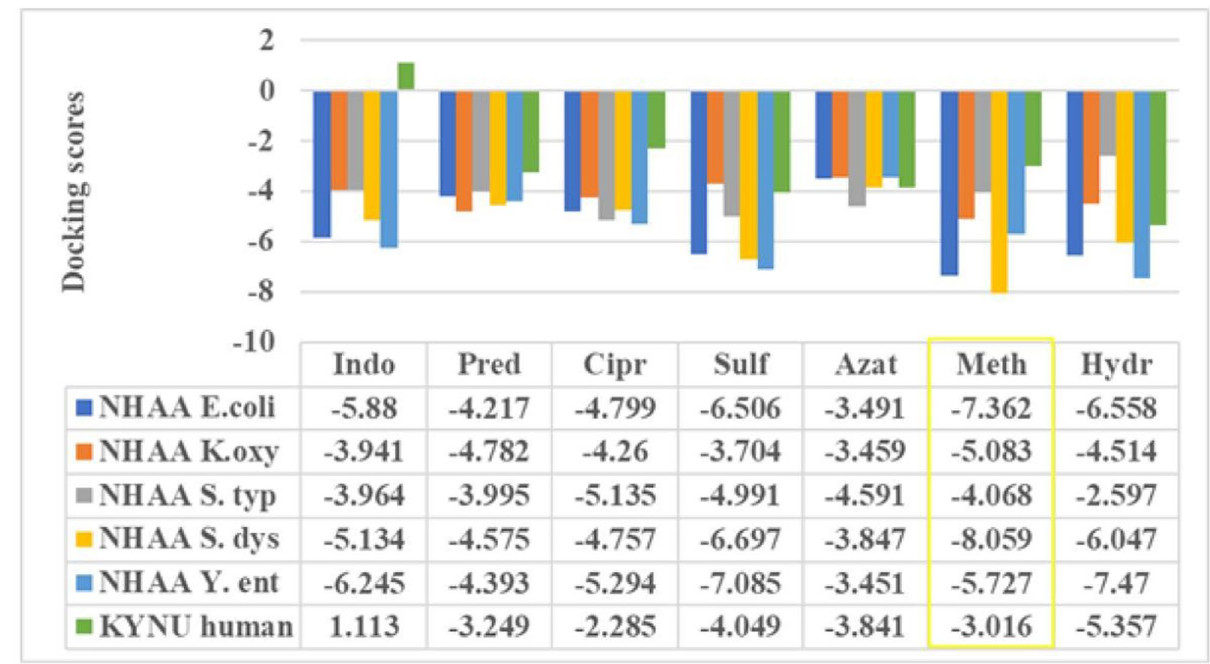
Figure 5. Docking scores of drugs utilised in IBD and ReA against NHAA and